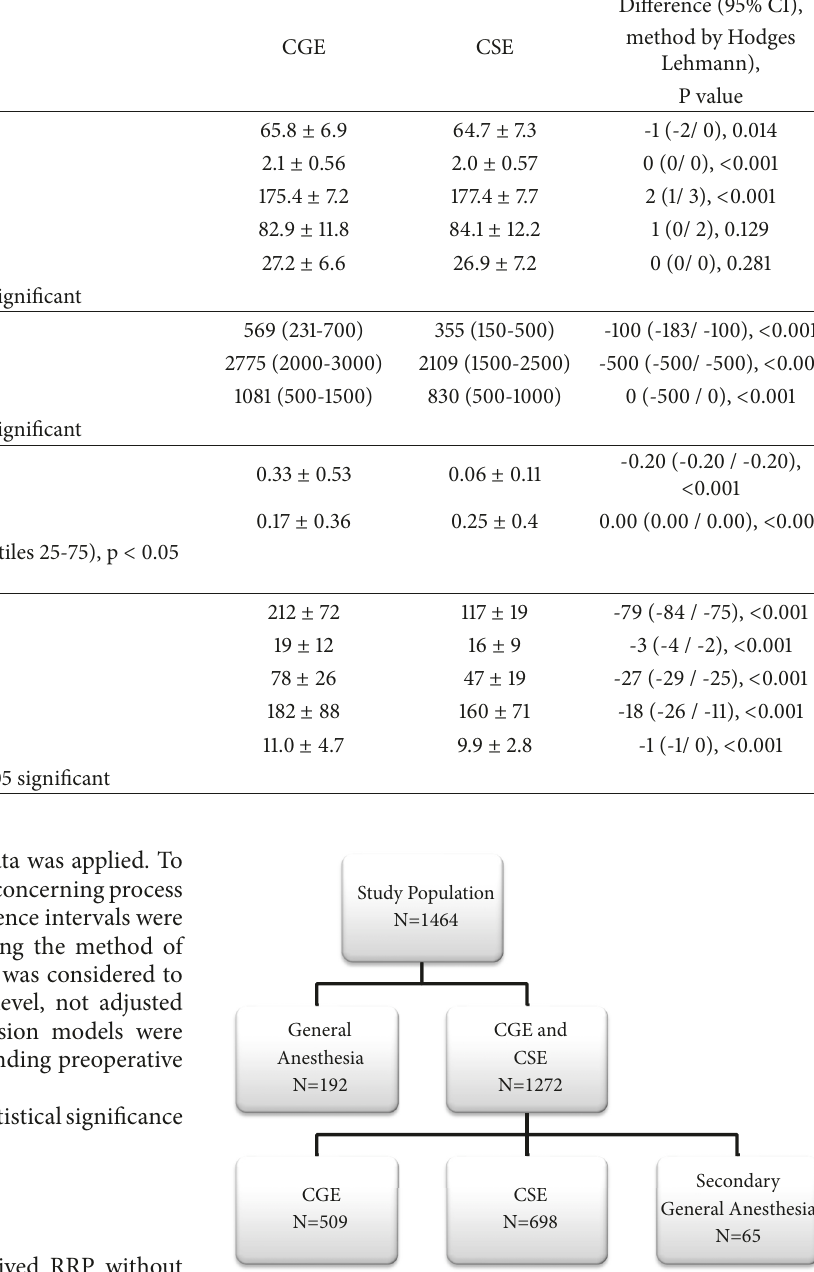
Figure 1: The figure depicts the study population and subgroup distribution : CGE: combined general epidural anesthesia; CSE: combined spinal epidural